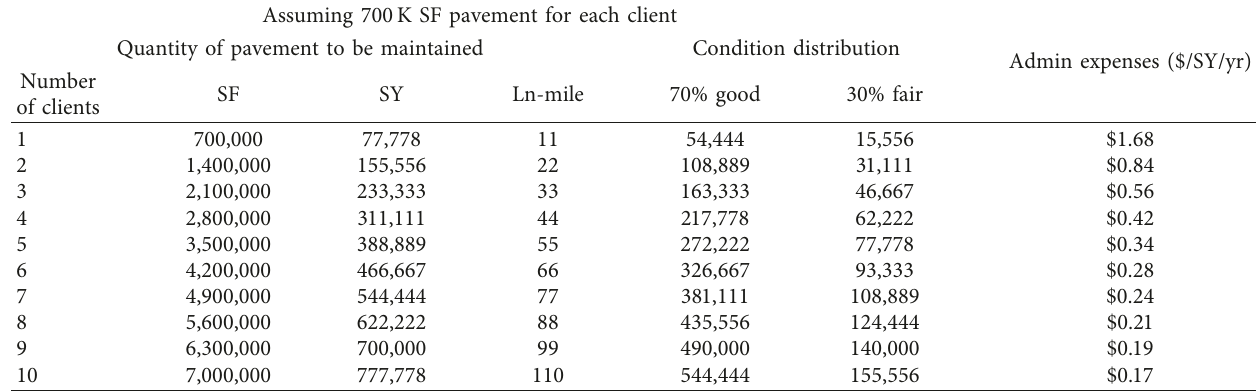
Table 4: Annual admin expenses per SY.